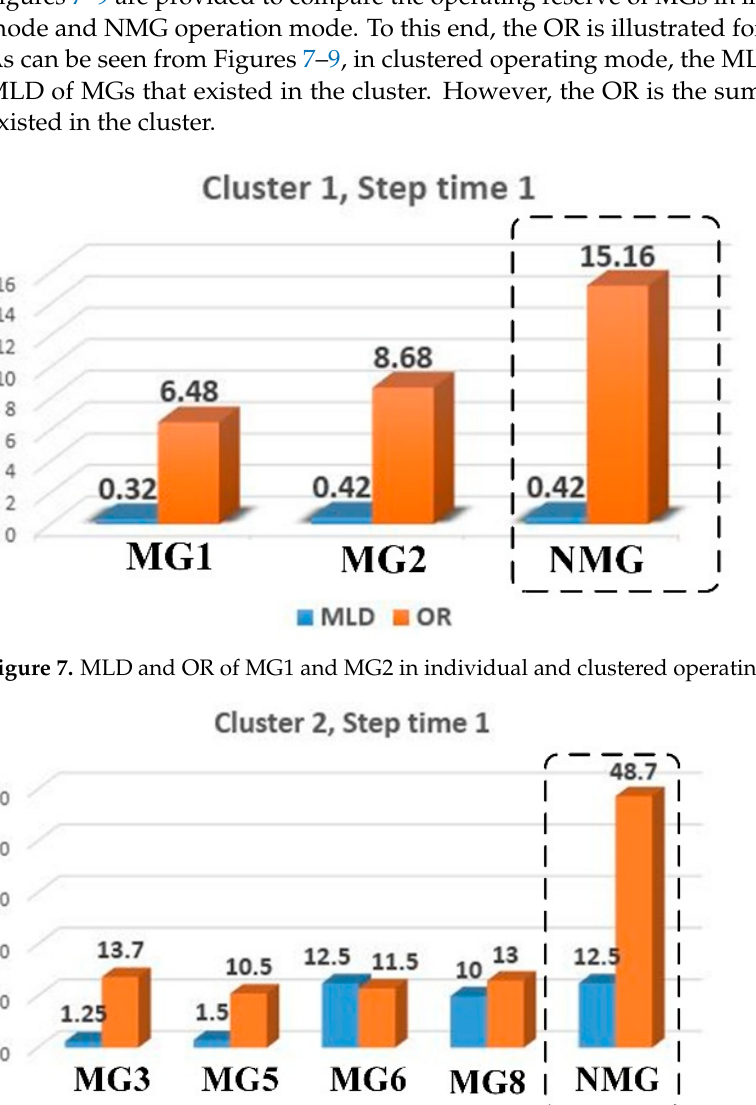
Figure 9. MLD and OR of MG4 and MG7 in individual and clustered operating mode. 5. Conclusions This paper applies supervised and unsupervised learning clustering to an NMG con- sisting of residential, commercial, and industrial MGs. By means of the SOM and k-means algorithm, the MGs are clustered such that the higher peak load MGs collaborate with higher operating reserve MGs in order to supply the loads efficiently. This control strategy can also affect component sizing and, consequently, the capital, replacement, and M&O cost of components by reducing the MGs’ peak loads. The employed EMS offers several advantages to the system: the clustered MGs can perform effectively in this control strat- egy due to providing reliable and efficient operation for the clustered MGs even if losing power generation units accidentally; the efficiency, security, and dynamic in the proposed networked microgrids is improved due to contributing the MGs in case of encountering DER output variation; the system can expedite the restoration of electricity services in case of facing extreme event disruptions such as natural disasters and massive cyber or physi- cal attacks.